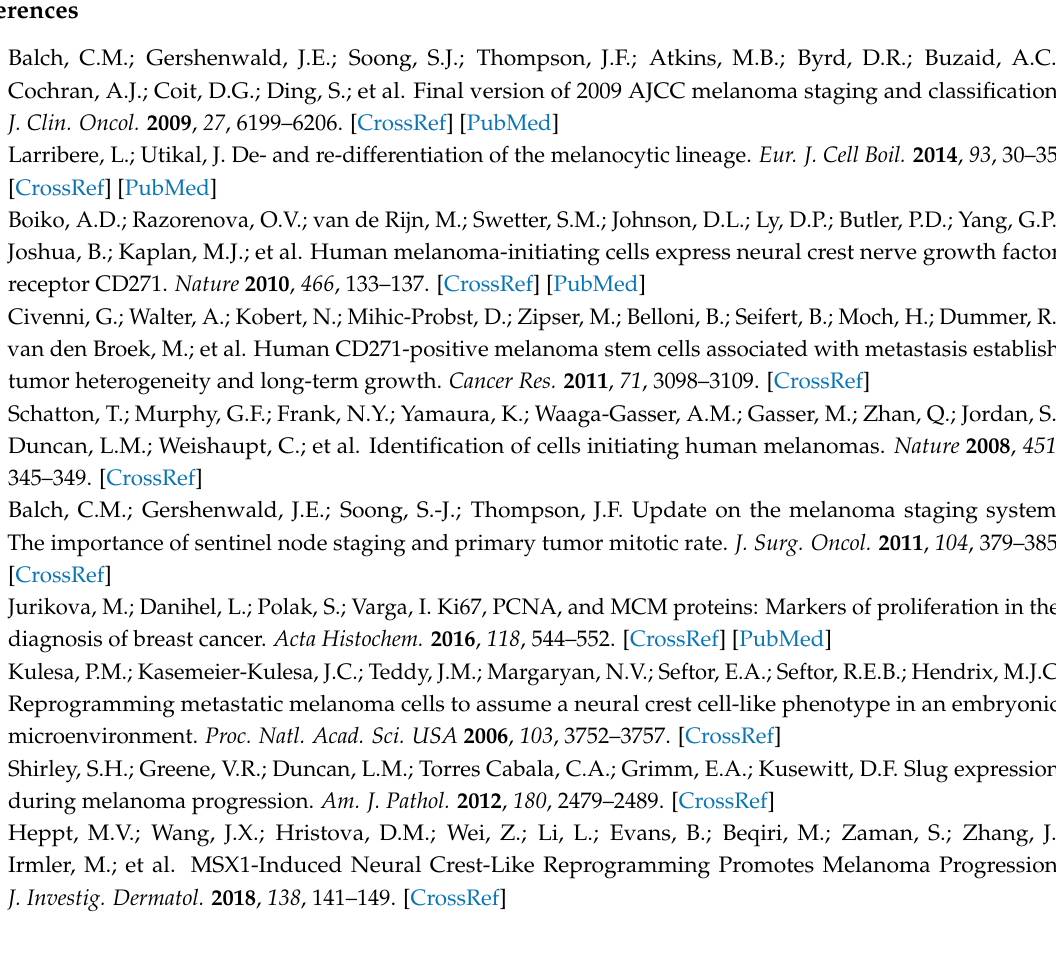
Figure S1: IHC score of short-term survival and long-term survival. IHC score analyses of the two subgroups (short-term survival and long-term survival) are displayed in this chart. Y-axis shows the overall IHC score (0–12), which was calculated as the product of quantity and intensity of the staining. Displayed antibodies did not show significant difference. Figure S2: IHC score in high-risk group A and high-risk group B. IHC score analyses of the two subgroups (high-risk group A and high-risk group B) are displayed in this chart. Y-axis shows the overall IHC score (0–12), which was calculated as the product of quantity and intensity of the staining (not significant). Figure S3: Intensity of TMA stainings. Immunohistochemical stainings are shown for survival group (CD271, GLDC, and ERRFI1) in S100- β -positive melanoma cells. Samples with, mild, moderate, and strong intensity (12 × and 80 × magnifications) are shown. Figure S4: Intensity of TMA stainings. Immunohistochemical stainings